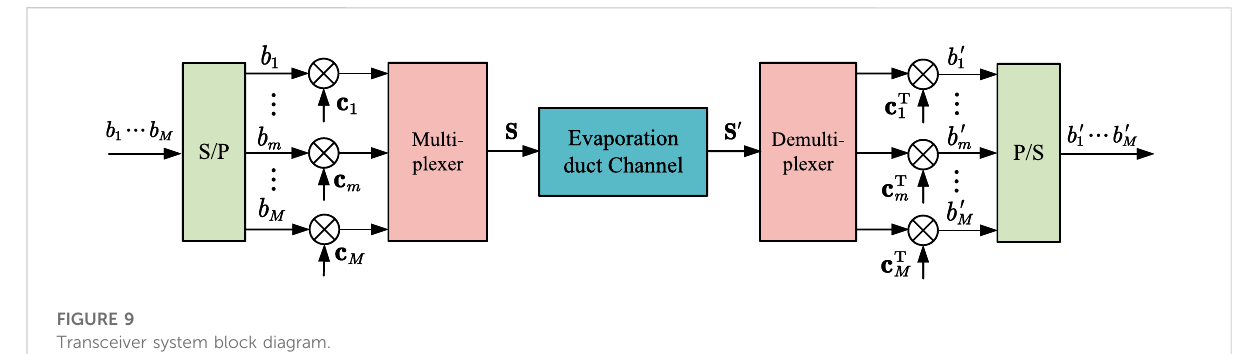
FIGURE 9 Transceiver system block